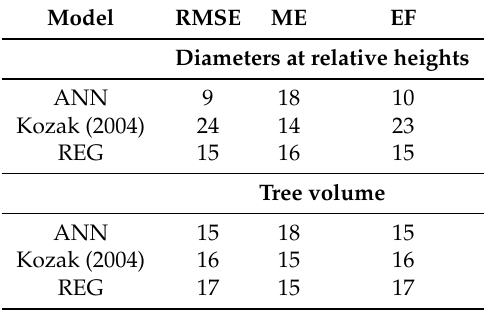
Table 4. Ranks of estimation errors for the diameters and volume for the three models on testing sets. Model RMSE ME EF Diameters at relative heights ANN